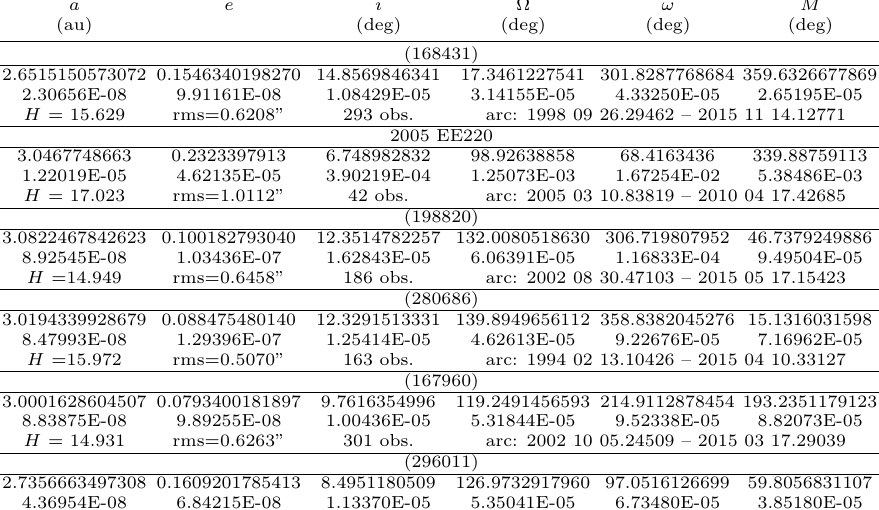
Table 3. High precision orbital elements of the asteroids discovered at the Mol_etai Observatory in 2005{2007. The epoch JD2457200 = 2015 June